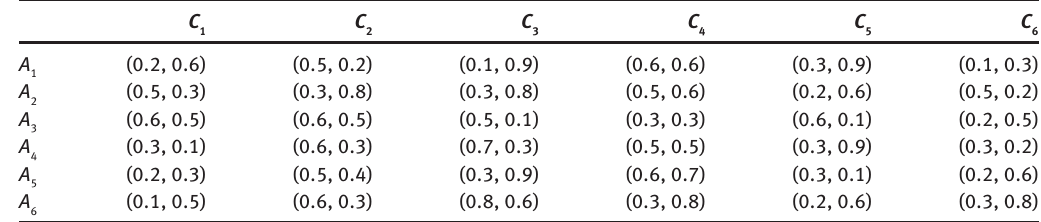
Table 3: Characterization of the Investments of Expert 3.